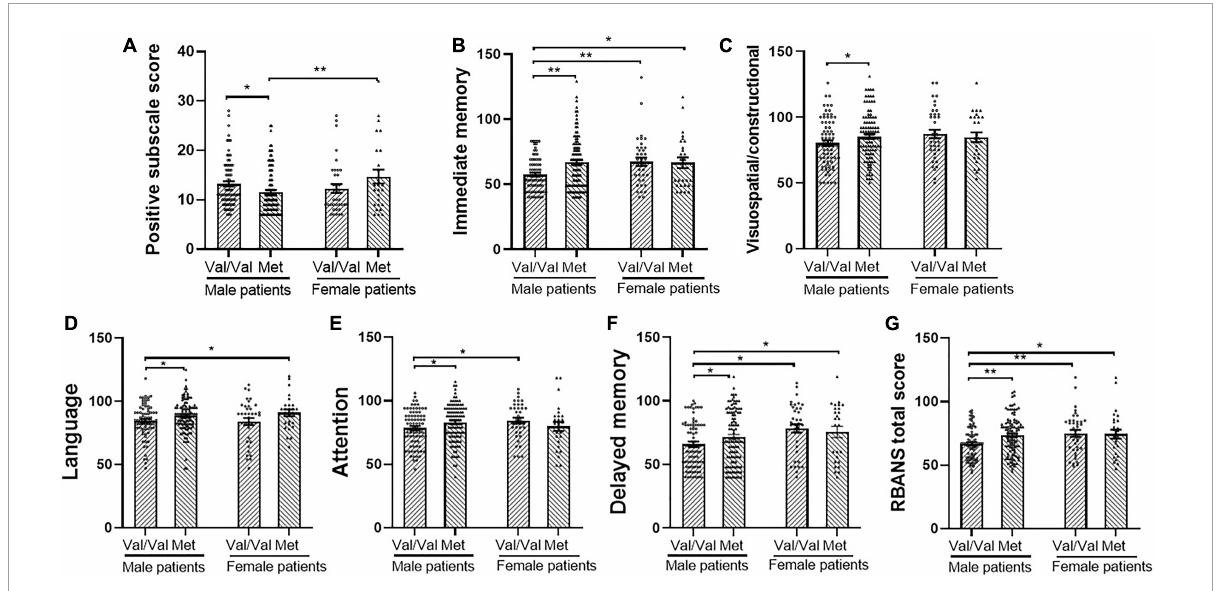
FIGURE1 Comparisons between catechol O methyl transferase Val158Met (rs4680) genotype and sex with post hoc test on positive symptom and cognitive performance. (A) Positive and negative syndrome scale (PANSS) positive subscale score, (B) immediate memory, (C) Visuospatial/constructional, (D) Language, (E) Attention, (F) Delayed memory, and (G) Repeatable battery for the assessment of neuropsychological status (RBANS) total score. Error bars: standard error of the mean. p : ∗ < 0.05, ∗∗ < 0.01. Met means Met